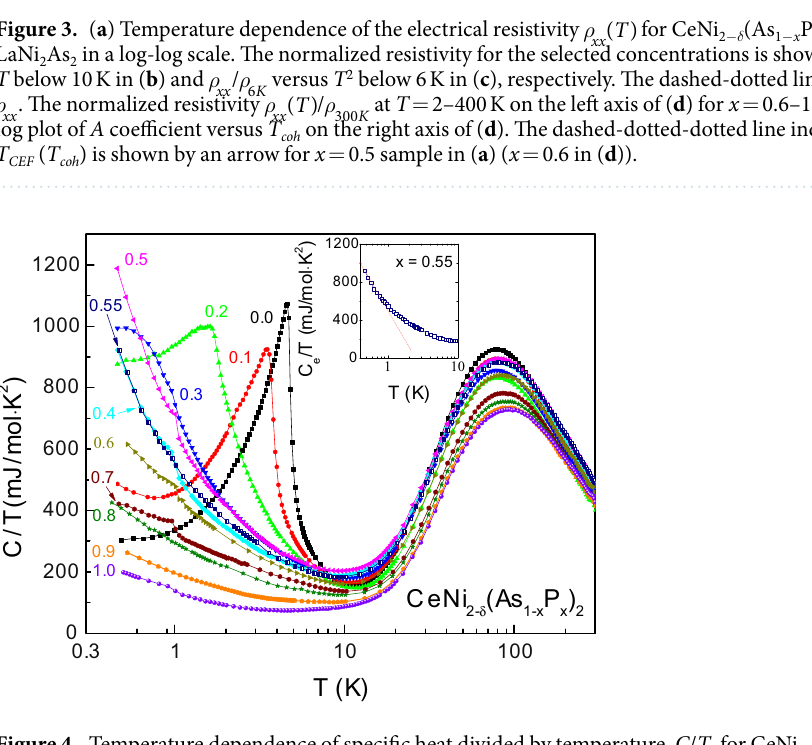
from the derivative of C T T ( )/ at the sharp kink. For x = 0.0–0.4, the peak broadens and moves to lower tempera- ture with increasing the P-content x . For x = 0.5, C T T ( )/ increases drastically down to our base temperature while